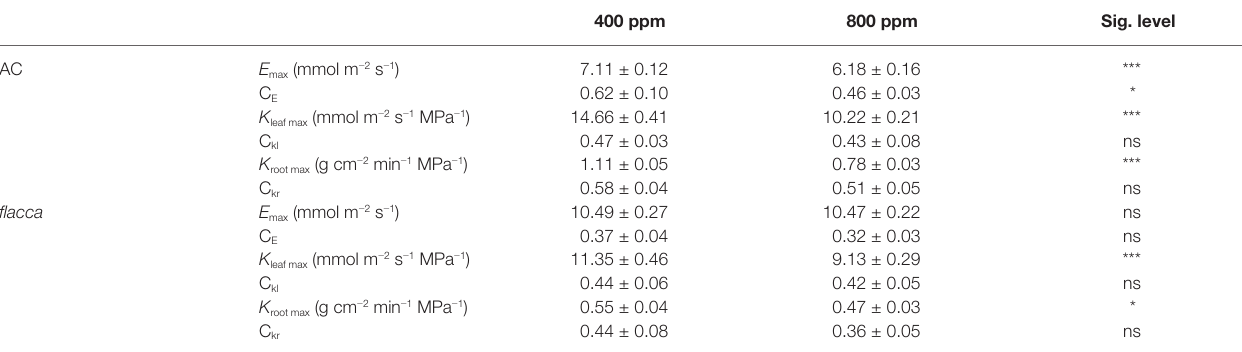
TABLE 1 | Output of statistical analysis of parameters derived from the linear-plateau regression of transpiration rate ( E ), leaf and root hydraulic conductance ( K leaf and K root ) of AC and flacca grown under ambient (400 ppm), and elevated (800 ppm) atmospheric CO 2 concentrations response to the reduction in fraction of transpirable soil water